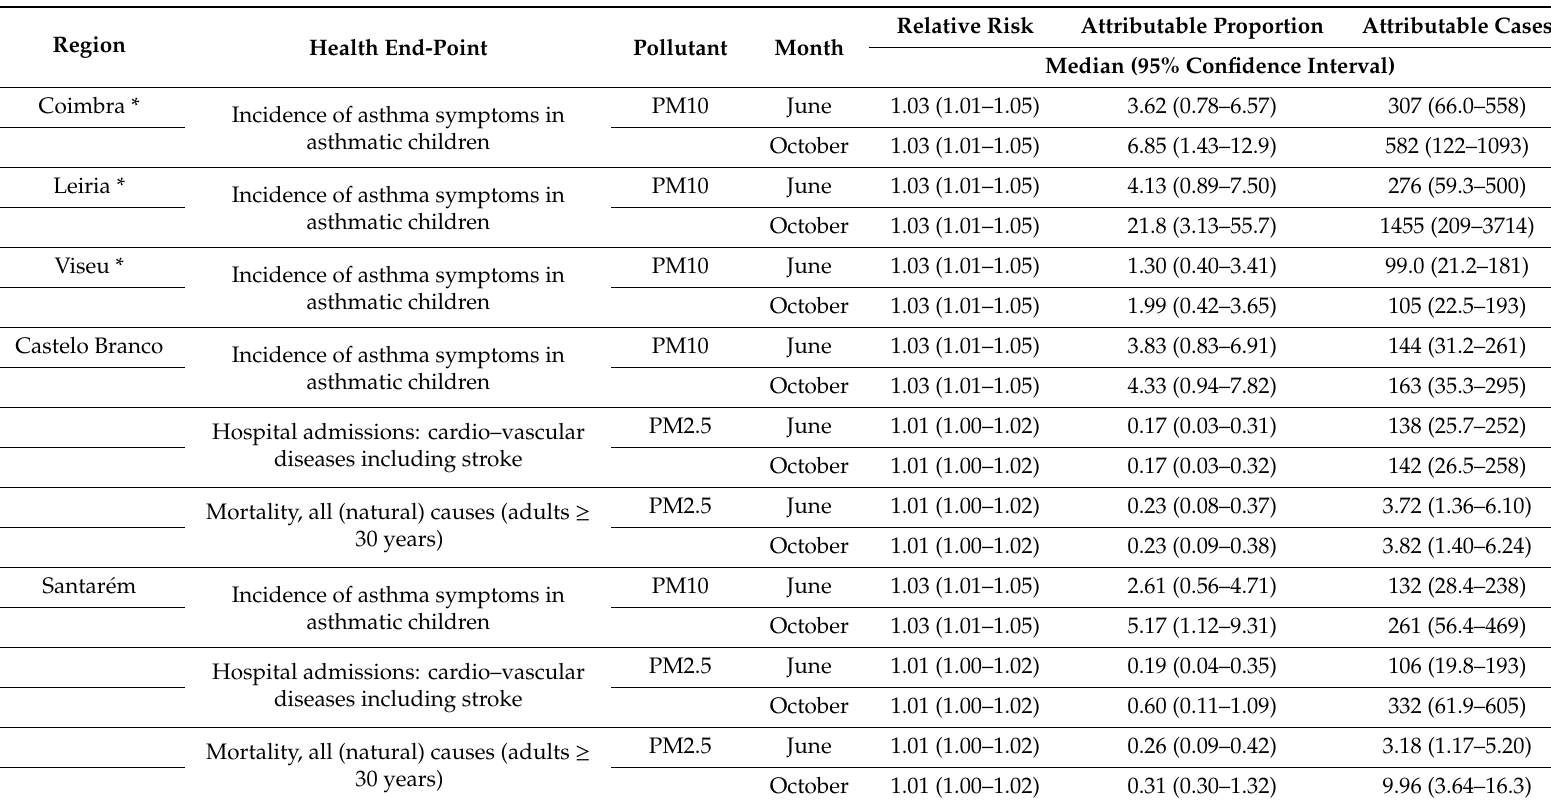
Table 1. Estimated attributable proportion (%) and cases (per 100,000 population at risk) of short-term health end-points estimated by AIRQ + software [63] for the regions that included the districts under study due to PM 10 and PM 2.5 exposure levels in June and October